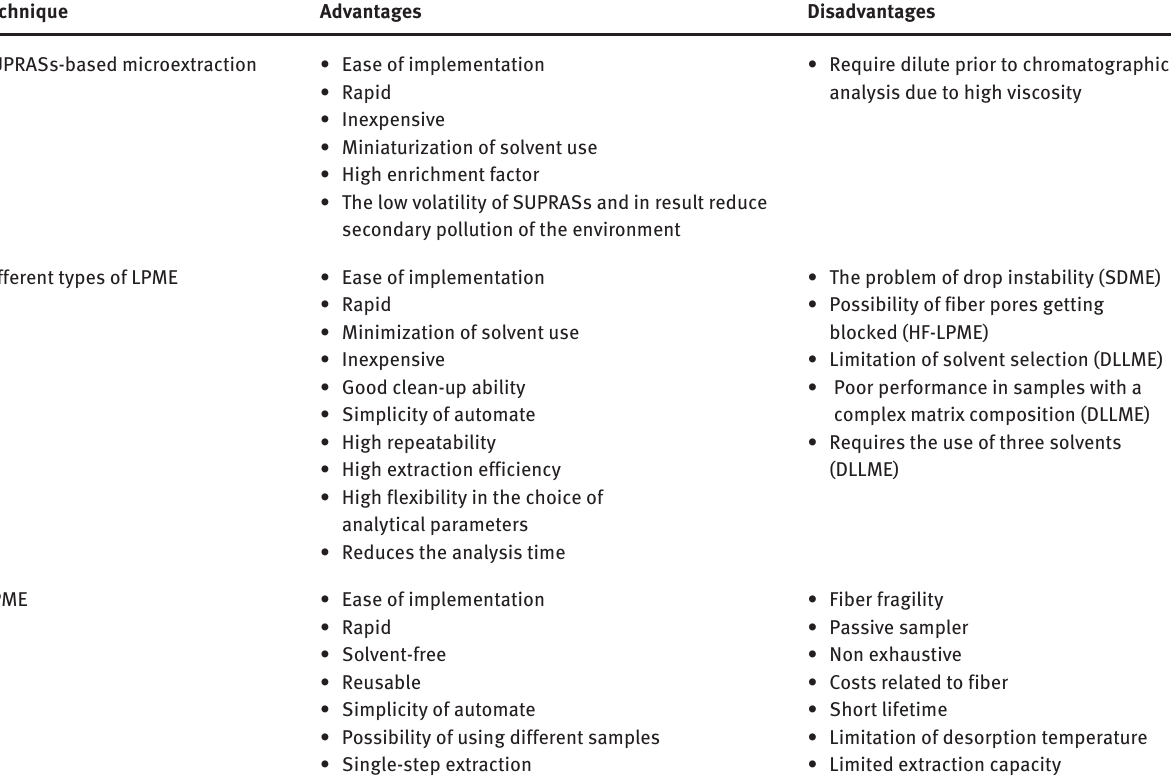
Table 1: Strengths and weaknesses of different microextraction techniques